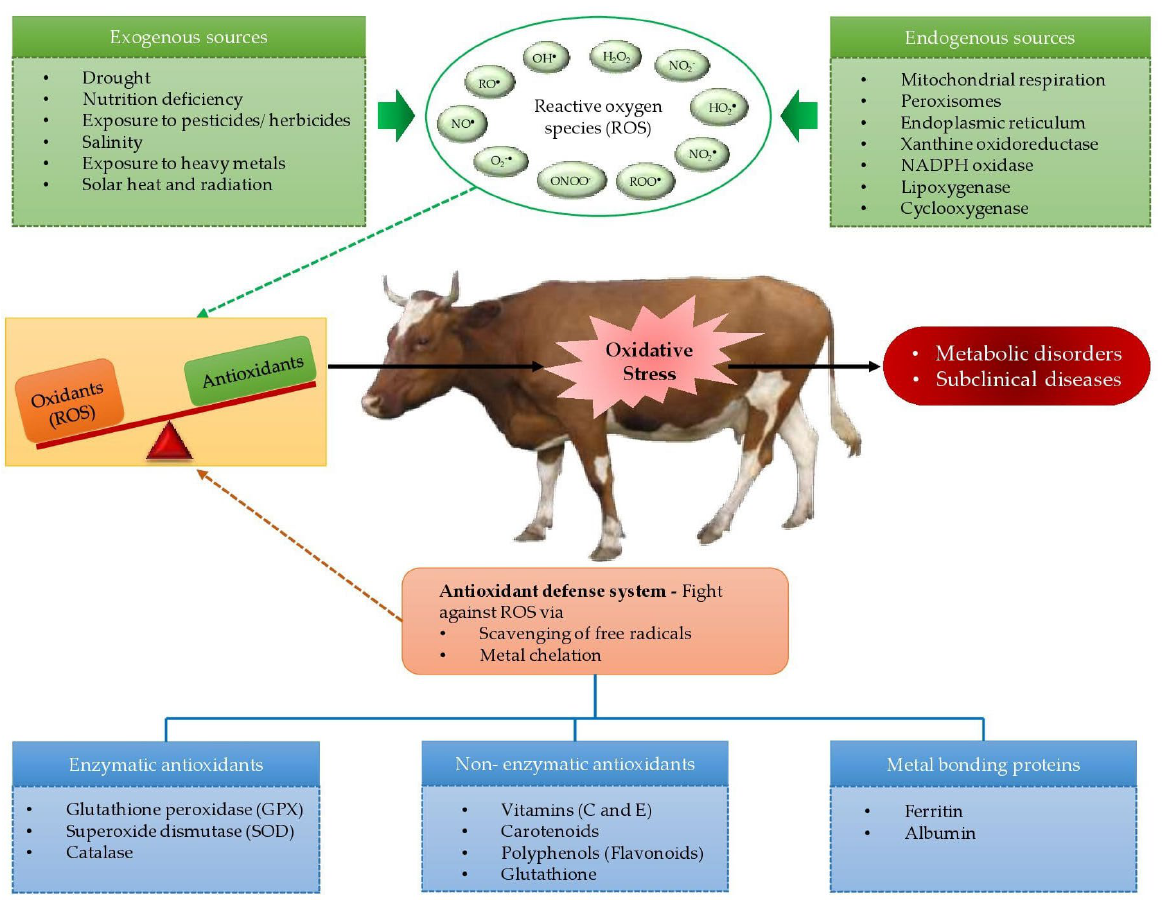
Figure 4. Development of oxidative stress in farm animals. ROS are generated by the induction of exogenous and endogenous sources. Enzymatic antioxidants, non-enzymatic antioxidants, and metal-binding proteins in the body fight against ROS via free radical scavenging and metal chelation mechanisms. When there is a disequilibrium between the ROS and antioxidants, ROS production will continuously increase and result in the development of a state called oxidative stress.